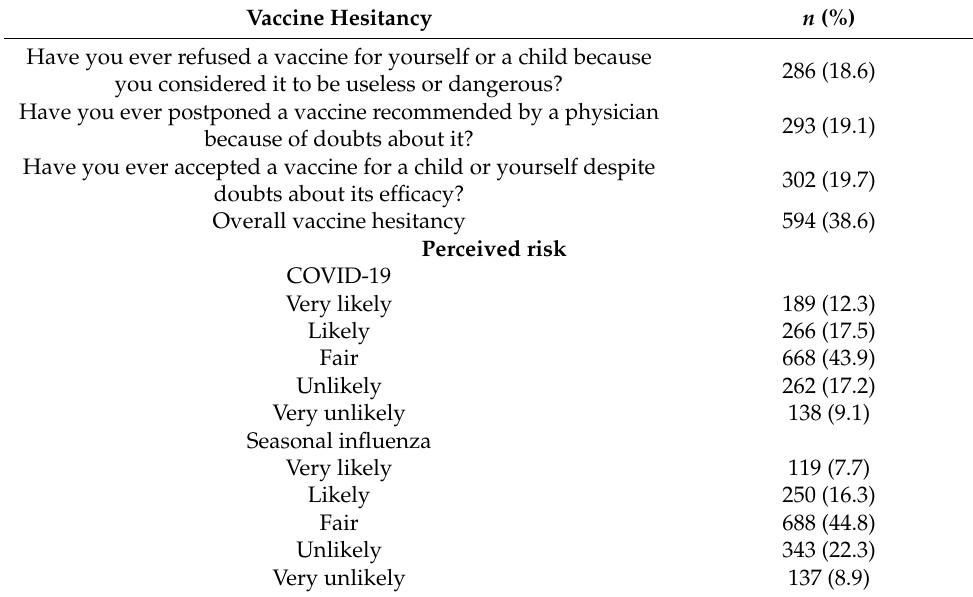
Table 2. Vaccine hesitancy and intention to be vaccinated among the study